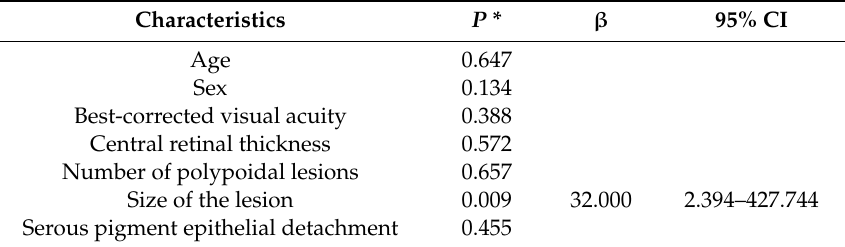
Table 2. Multivariate analysis of factors associated with lesion